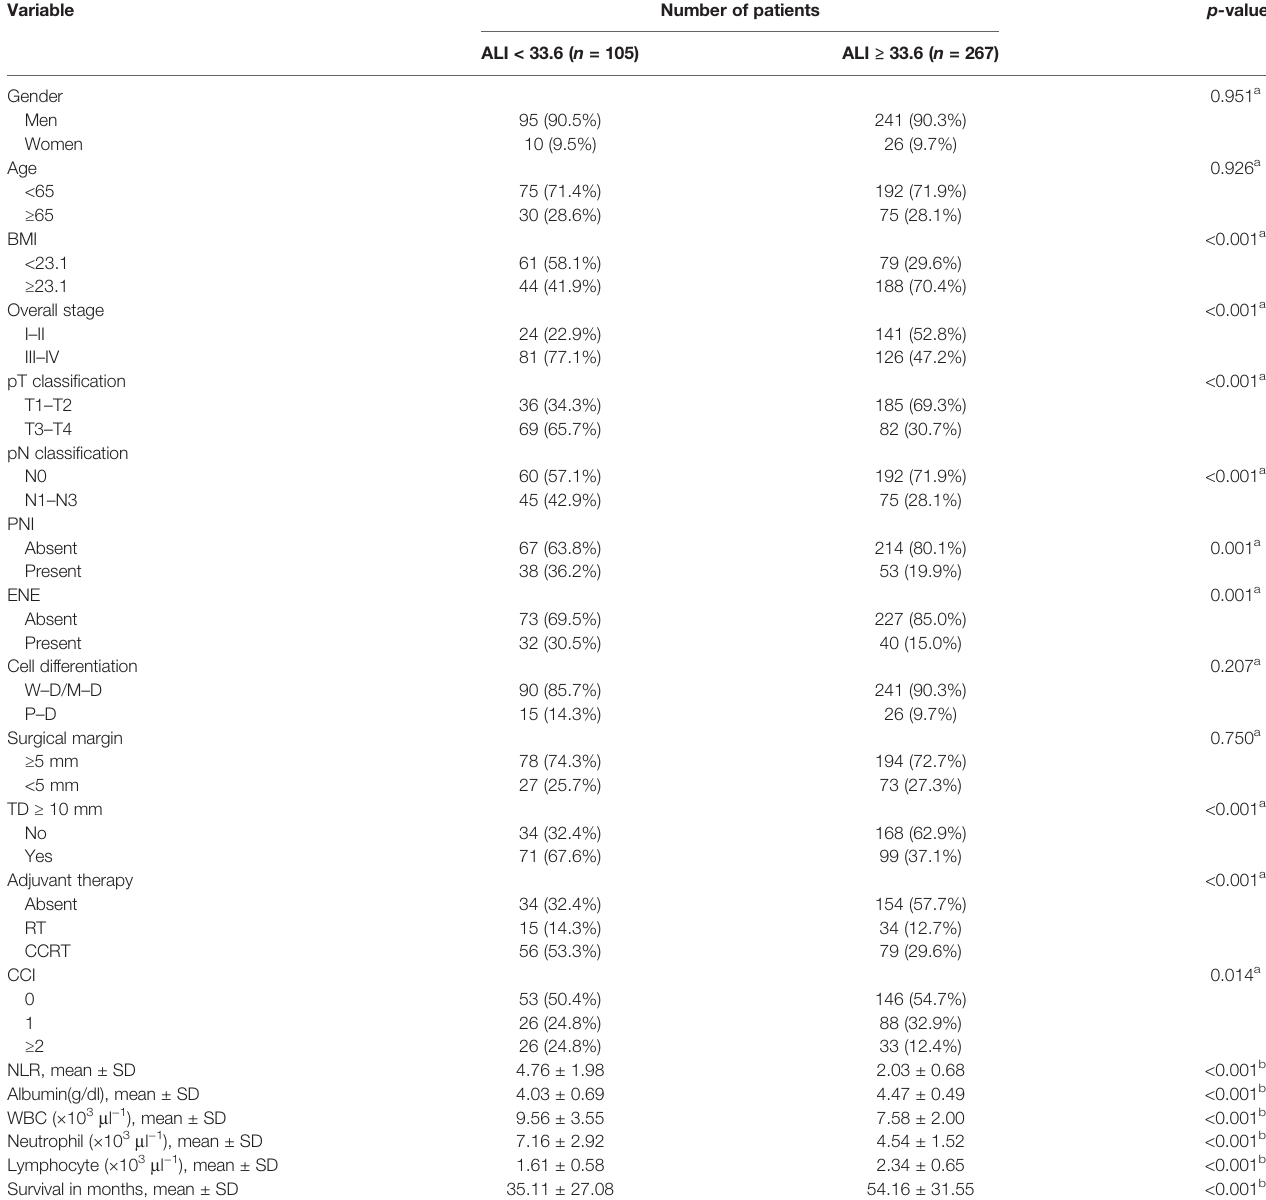
TABLE 3 | Baseline clinicopathological characteristics according to the